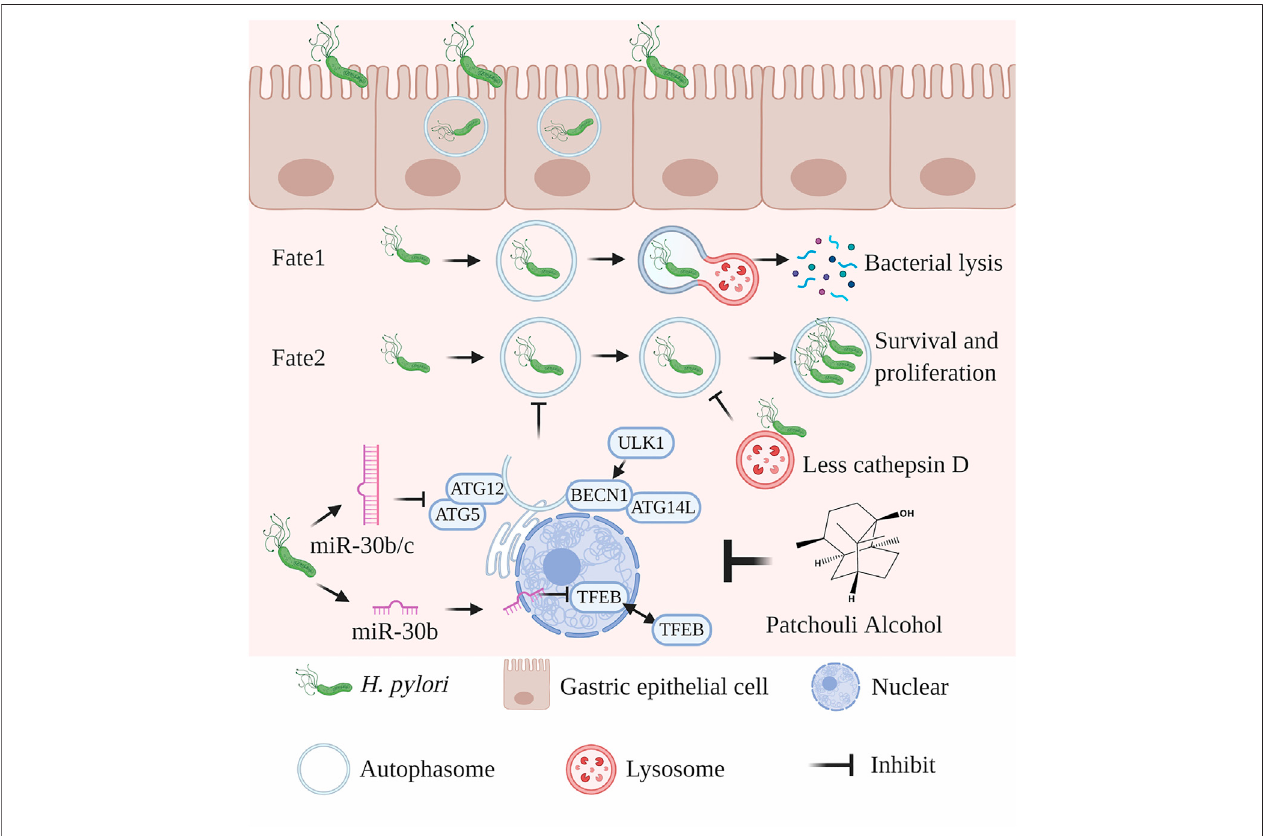
FIGURE9| ProposedmechanismofPAagainstintracellular H.pylori .Some H.pylori bacteriacouldinvadegastricepithelialcells.Intheearlystagesofinfection, H. pylori is enveloped by autophagosomes, which then fuse with lysosomes to form autolysosomes and digest the bacteria. As infection progresses, intracellular H. pylori secretes several toxic factors, such as VacA, to inhibit the xenophagic fl ux. The expression of miR-30c-3p, miR-30c-5p, and miR-30b-5p is typically upregulated by H. pylori infection and results in the downregulation of ULK1 , ATG5 , ATG12 , and ATG14 and inhibition of the formation of autophagosomes. MiR-30c-5p could be transferred to the nucleus to inhibit the functions of TFEB and lysosomes. PA upregulates the expression of miR-30c-3p, miR-30c-5p, and miR-30b-5p to promote the xenophagic fl ux and lysosome function. The fi gure was created using BioRender.com supported by the Postdoc plan.